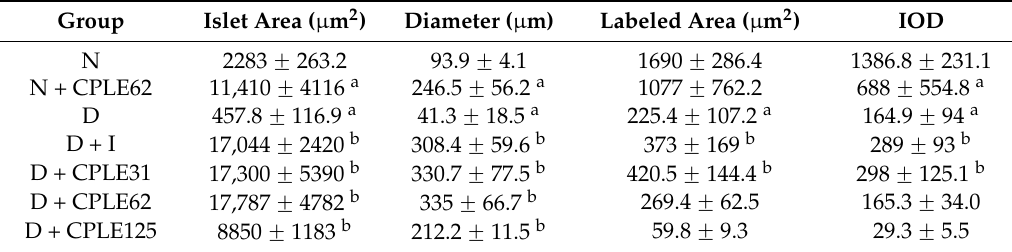
Table 2. Effect of the chloroform extract of C. papaya on the Pancreas islet.